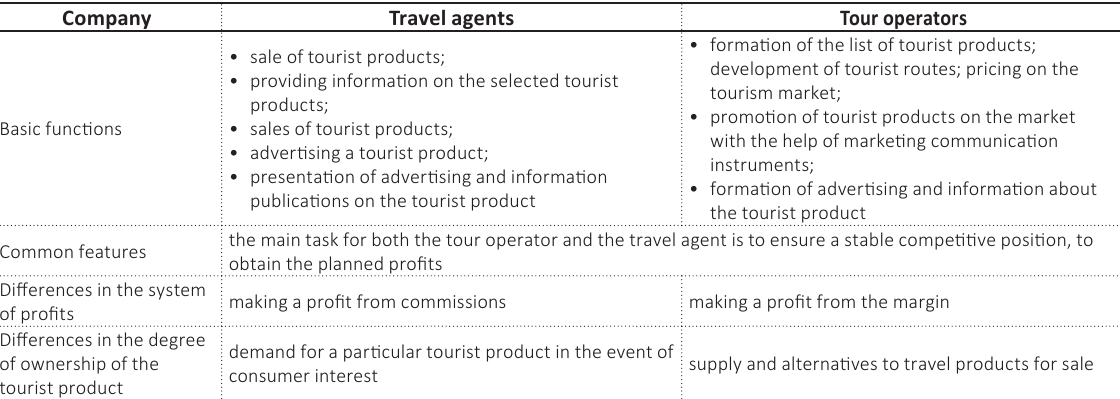
Table 5. Comparison of main activities of tourism infrastructure